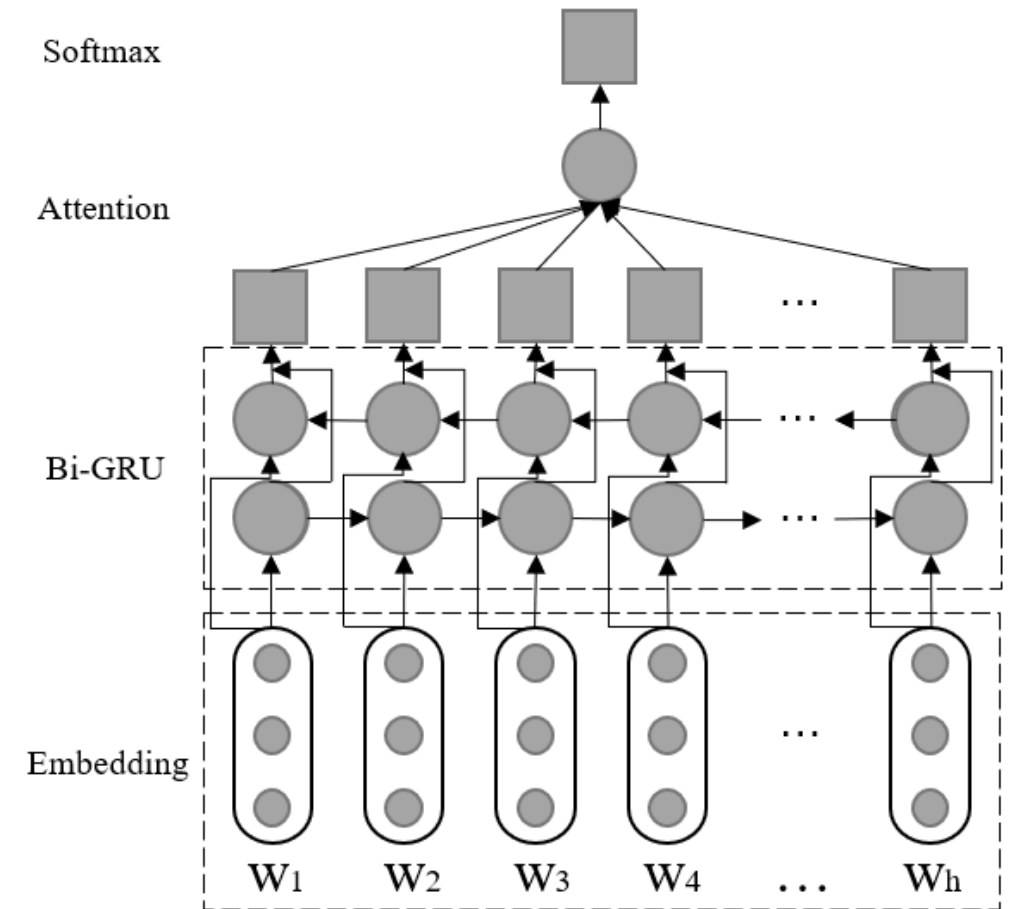
Figure 2. Structure of the text classification